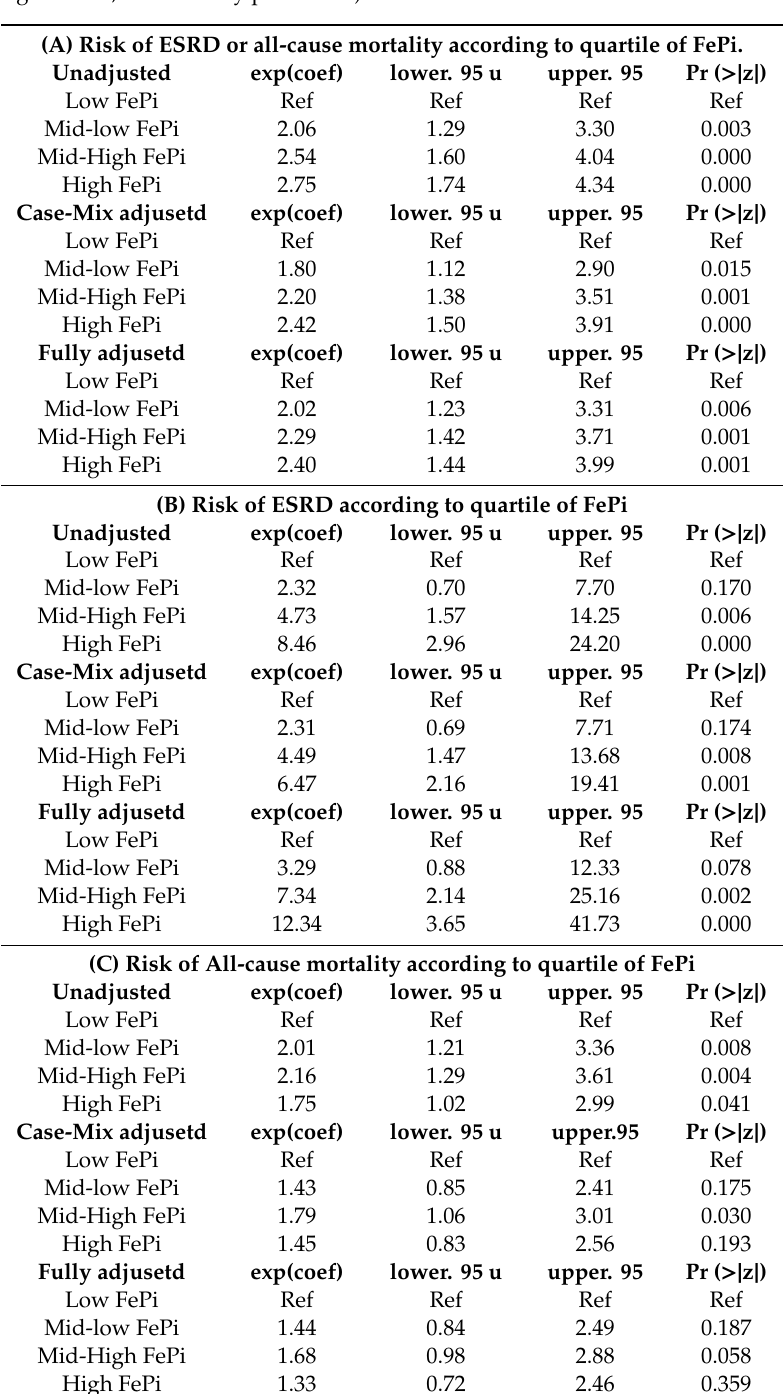
Table 4. time to event according to quartiles of Fractional Excretion of Phosphate (FeP). ( A ) time to the composite endpoint of all-cause mortality or progression to ESRD; ( B ) time to the progression to ESRD; ( C ) time to all-cause mortality. Analysis for each endpoint are presented unadjusted, adjusted for the case-mix (age, CVD, Hypertension, Diabetes, Systolic and diastolic blood pressure, renal function) and fully adjusted (case-mix and protein intake, azotemia, albumin, serum phosphate, parathyroid hormone, triglicerides, 24-h urinary